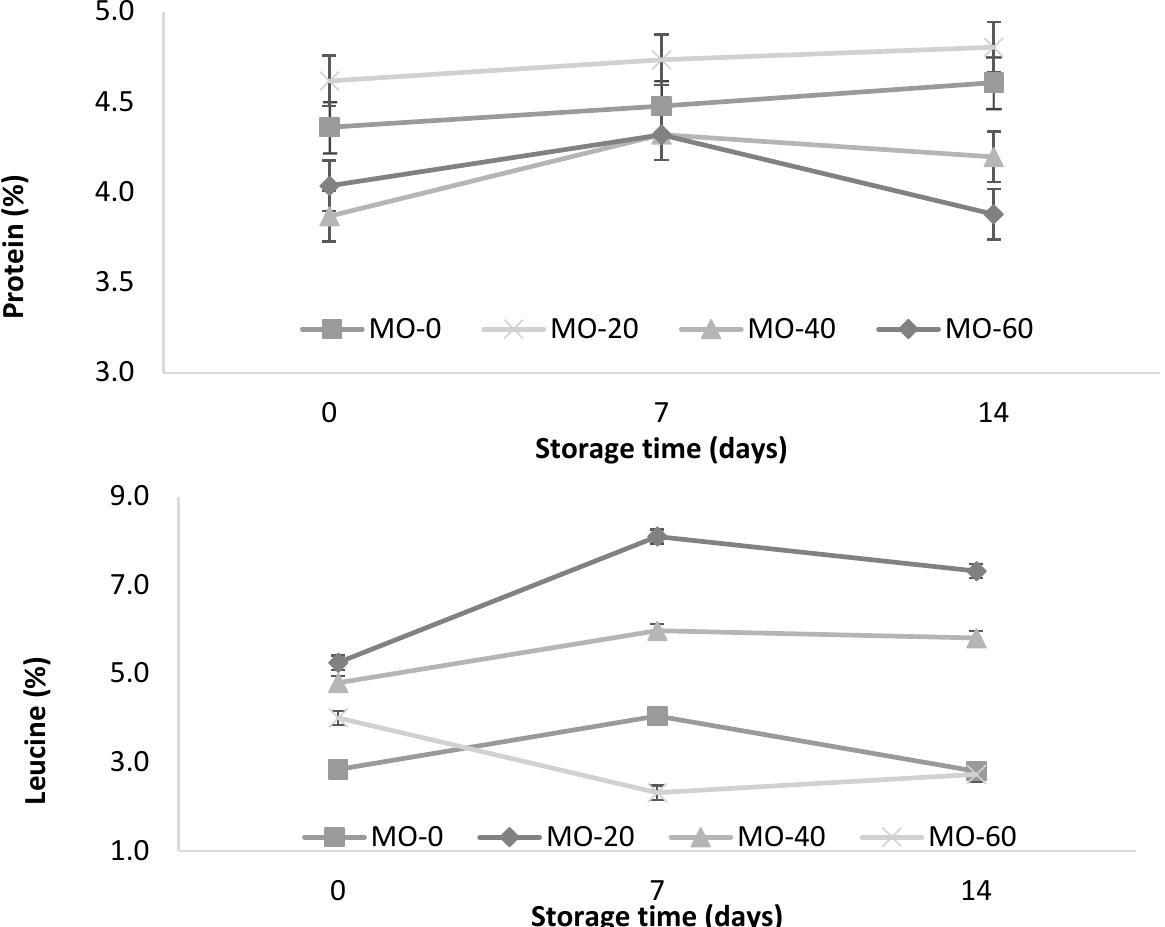
Figure 2. Storage changes in protein and leucine contents of yogurt from sheep fed with Moringa oleifera extracts. Bars denote standard error of the means.